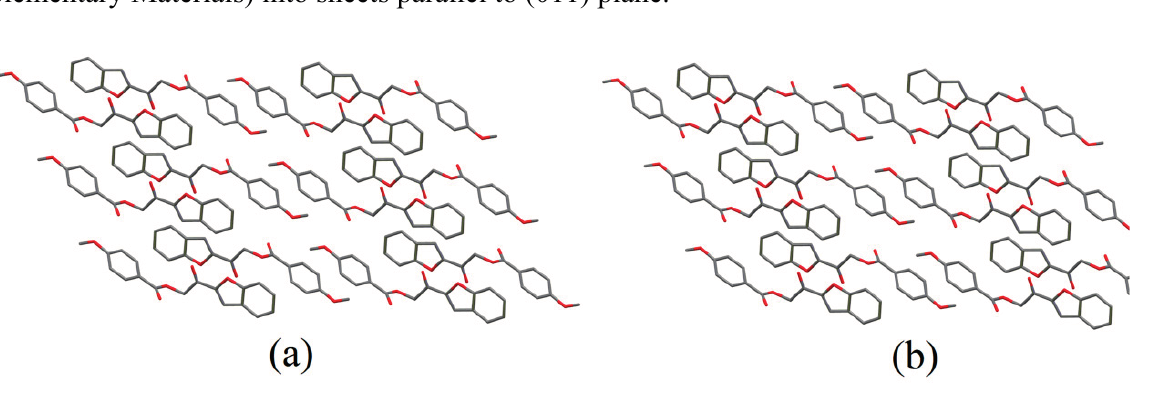
Figure 7. Two-dimensional structural similarities in ( a ) 4c and ( b ) 4d